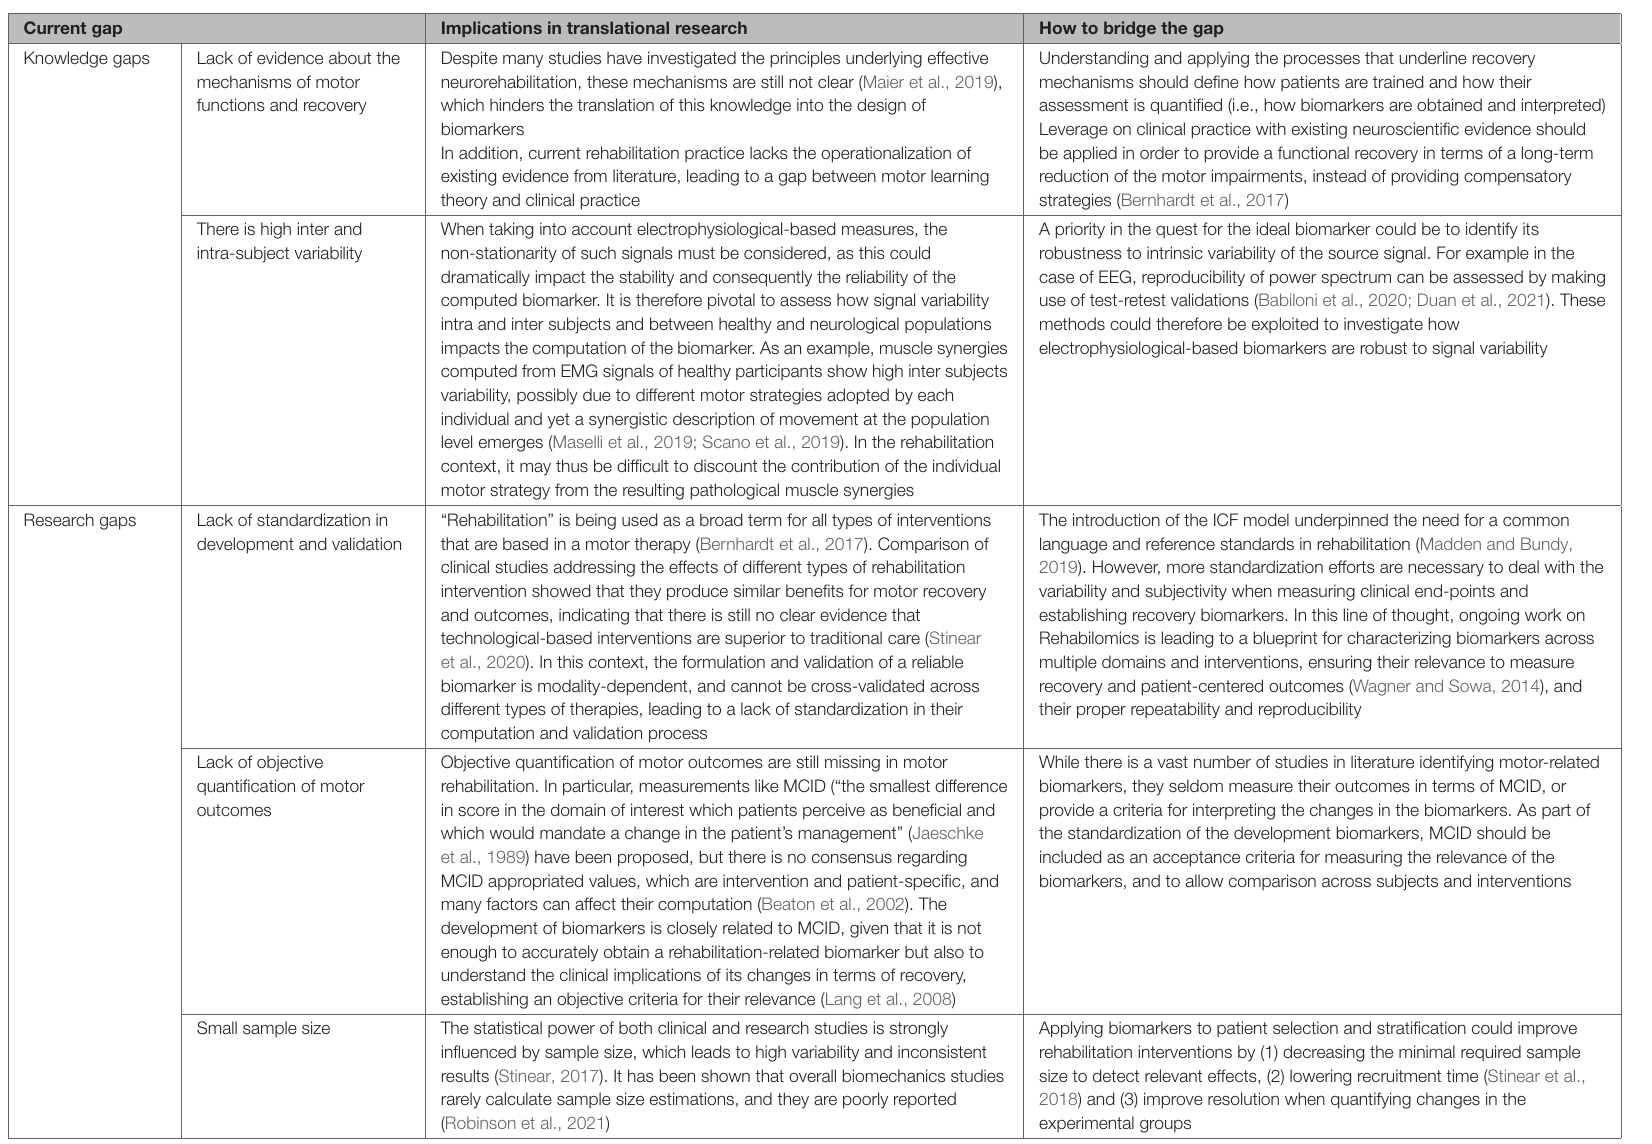
TABLE 4 | Current gaps and their implications in the translational